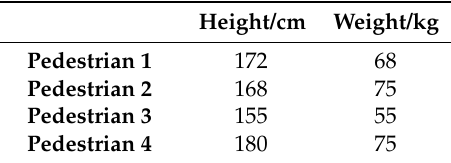
Table 3. Different pedestrians who collected crowdsourcing data in our experiment.